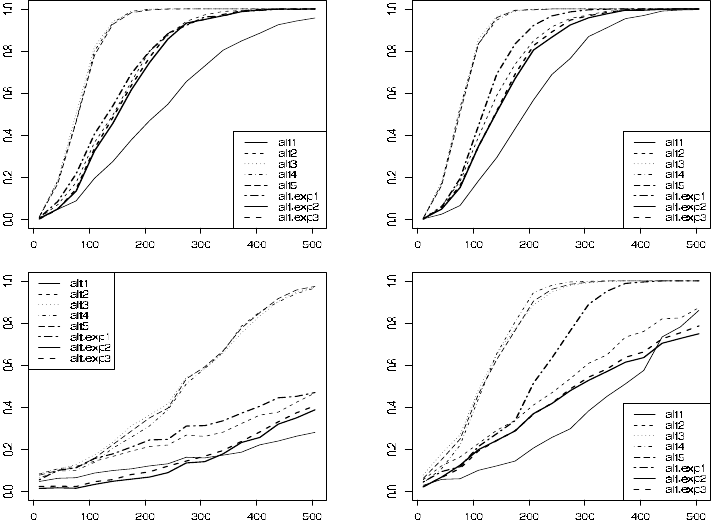
Figure 5. Empirical power plots for different alternatives (3.2) and (3.1) for models M 1 (top left plot), M 3 (top right plot), M 2 (bottom left plot) and M 4 (bottom right plot) with different sample sizes, based on 1000 replications. Kernel is U [ − 1 , 1] and h = h 0 n − 1 / 4 with h 0 = 0 .